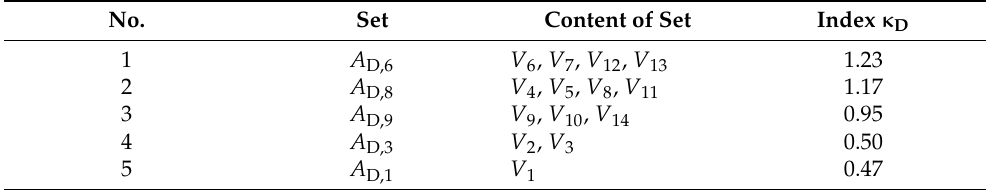
Table 8. A Ranking List of Sets A D, i i ∈ {1, 2, . . . , 14}, when the Index κ D is Adopted as a Criterion.